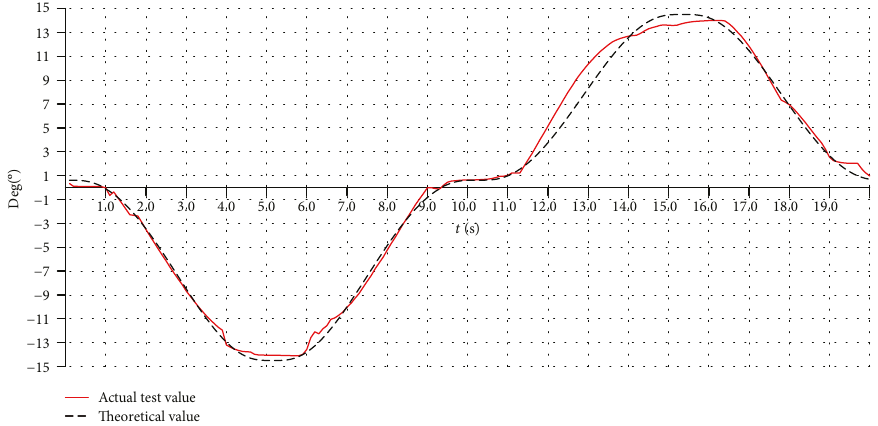
Figure 30: The working angles (from -15 ° to +15 ° ) for the varus/valgus rehabilitation motion tested on a human ankle